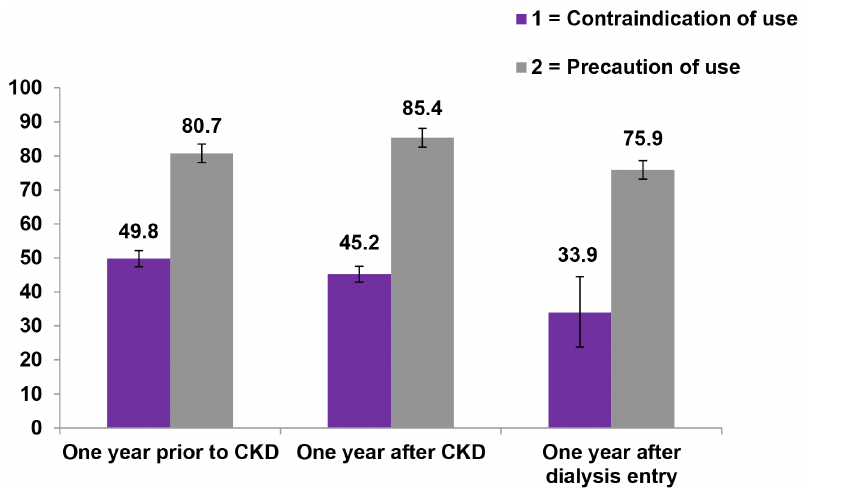
Figure 2. Proportion of incident CKD patients (N=1,989) who received at least one prescription of nephrotoxic drug. Proportion of incident CKD patients (N=1,989) who received at least one prescription of nephrotoxic drug within one year prior or after first CKD diagnosis, and within one year after dialysis entry (N=112).